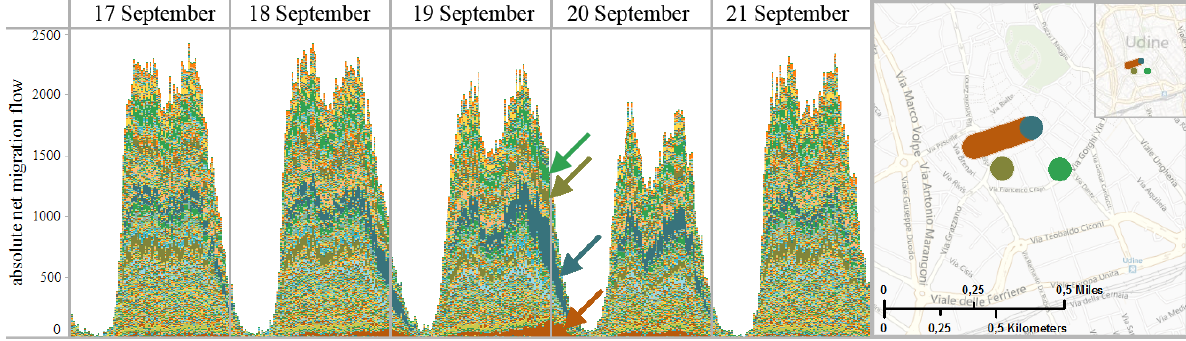
Figure 11. Unknown event in the Udine city center on Saturday night, 19 September 2009 (the color of the arrows correspond with the color in the